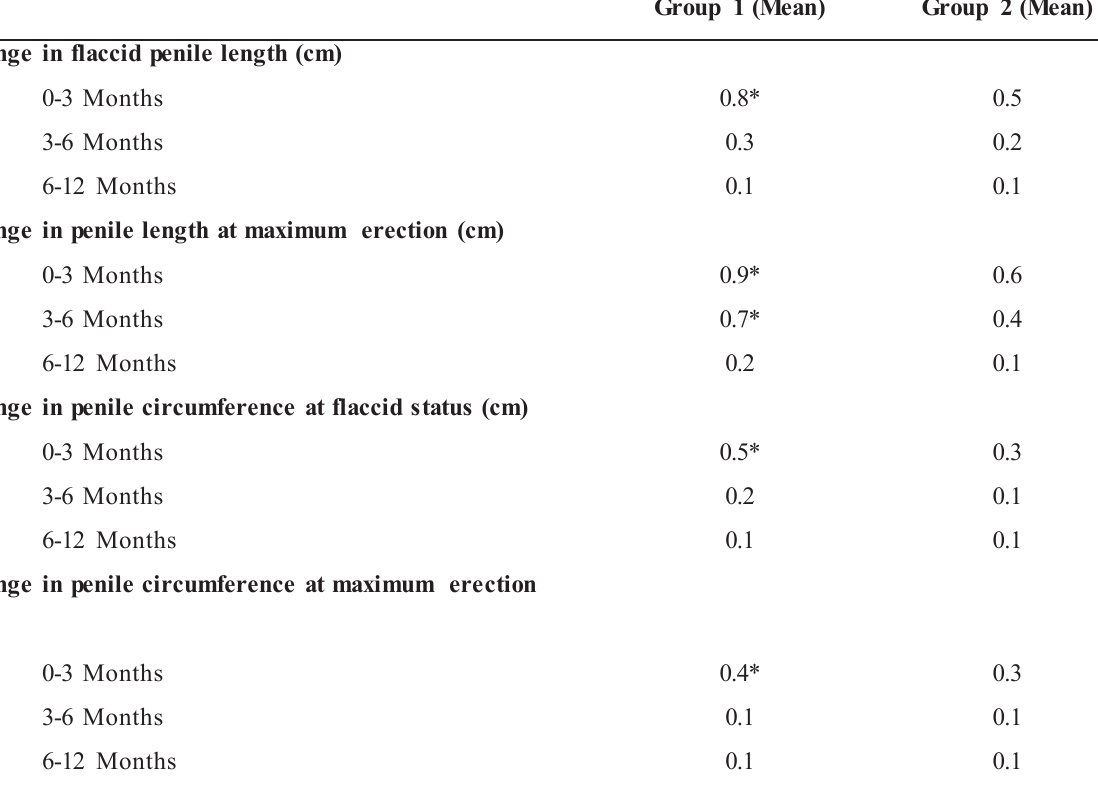
Table 2 – follow-up of changes of penile measurements (mean) of groups 1 and Table 2 - Follow-up of changes of penile measurements (mean) of groups 1 and 2